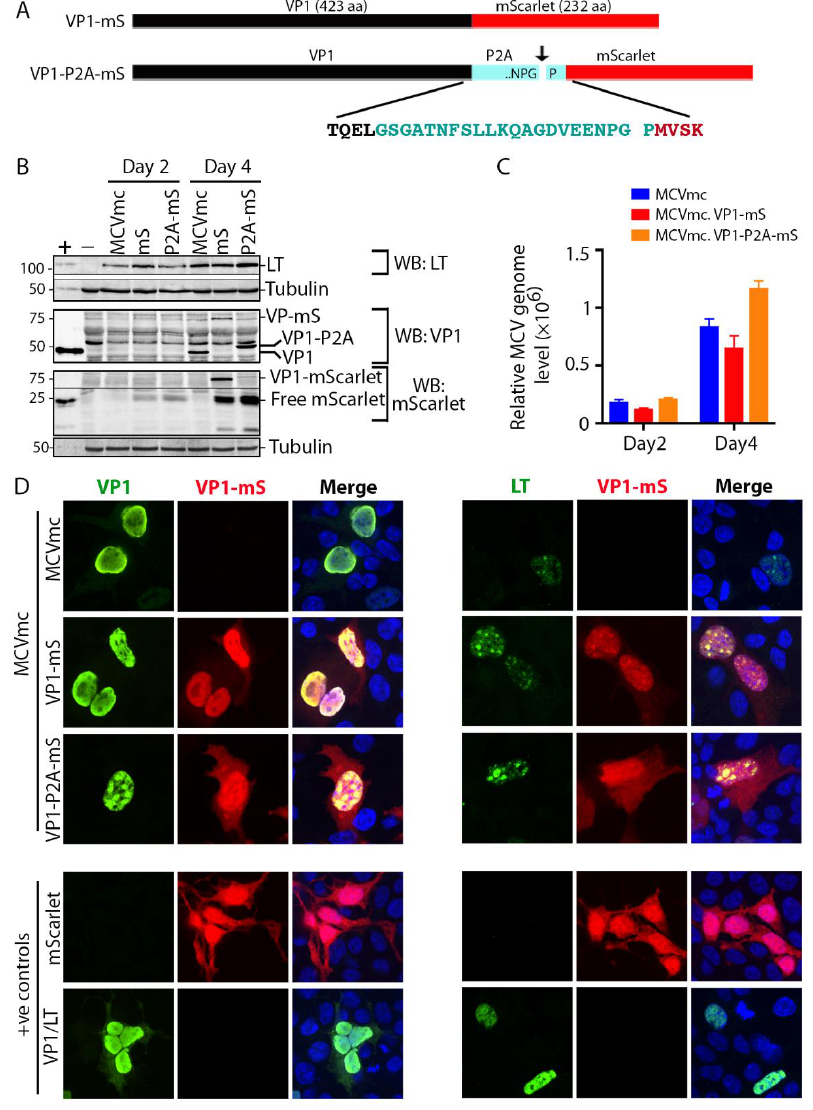
Figure 4. Generation of an mScarlet reporter MCVmc. ( A ) Schematic of VP1 fluorescent fusion constructs representing VP1 (black) containing mScarlet (red) tag in the presence (cyan) or absence of a P2A linker. Arrow indicates the P2A ribosome-skipping site and the whole P2A peptide sequence (cyan) is shown with four flanking amino acids from VP1 (black) and mScarlet (red). ( B ) Immunoblot of MCV-encoded proteins (LT and VP1) and mScarlet in 293 cells transfected with MCVmc, MCVmc.VP1-mS and MCVmc. VP1-P2A-mS after 2 and 4 days post transfection. Un-transfected 293 cells were used as a negative control ( − ), while 293 cells transfected with LT or VP1 expression construct were used as a positive control (+). α -tubulin was used as an endogenous protein-loading control. Protein molecular weight markers are shown on the left. ( C ) Quantification of DpnI-resistant replicated MCV DNA in 293 cells transfected with MCVmc, MCVmc.VP1-mS or MCVmc. VP1-P2A-mS 2 and 4 days post transfection qPCR results. The ∆∆ CT method was used to calculate relative MCV DNA levels; GAPDH was used as the endogenous loading control, while MCVmc was used as the experimental control. Error bars indicate ± SD of three independent replicates. ( D ) Confocal images of mScarlet expression (pseudo color red) and LT-AF488 (pseudo color green) or VP1-AF488 (pseudo color Green) immunofluorescence in MCVmc, MCVmc.VP1-mS and MCVmc. VP1-P2A-mS-transfected 293 cells 5 days post transfection. LT, VP1 or mScarlet expression construct-transfected 293 cells were used as positive controls. Images were originally acquired at × 40